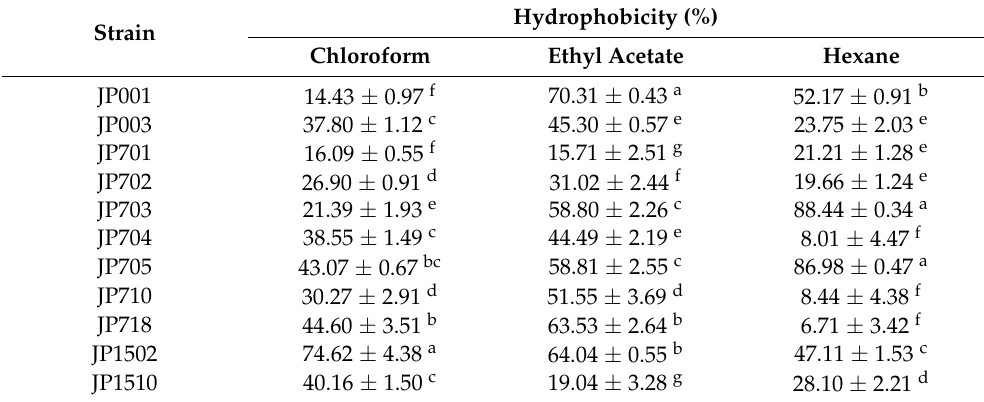
Table 5. Hydrophobicity percentage of LAB strains toward different